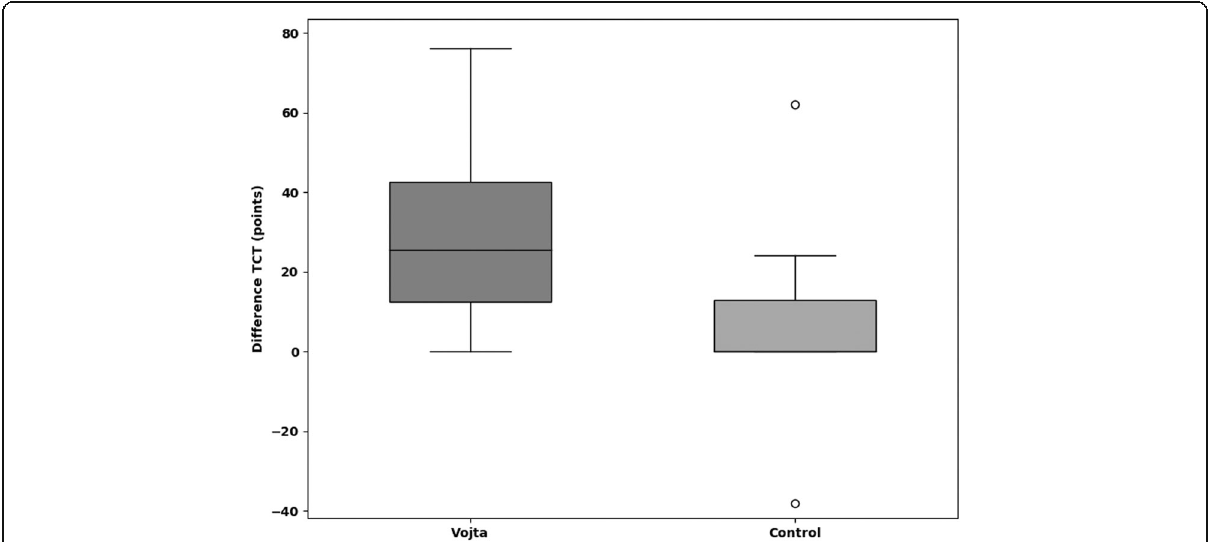
Fig. 2 Difference in Trunc control test (TCT) scores between baseline and day 9. The median improvement in the TCT within 9 days (primary outcome) was 25.5 points (=25.5%) (IQR 12.5 – 42.5) in the Vojta group and 0 (IQR 0 – 13) in the control group ( p = 0.001). Data are presented as box-and-whisker plots, in which the top and bottom of the rectangles indicate the 75th and 25th percentiles, respectively; the horizontal lines within the rectangles indicate the 50th percentile (median); the lines above and below the rectangles indicate the minimum and maximum of all of the data, so far as this are no outlier. Outlier are data lying outside the box > 1,5 lenghts of the box (IQR) and are presented as a small circle